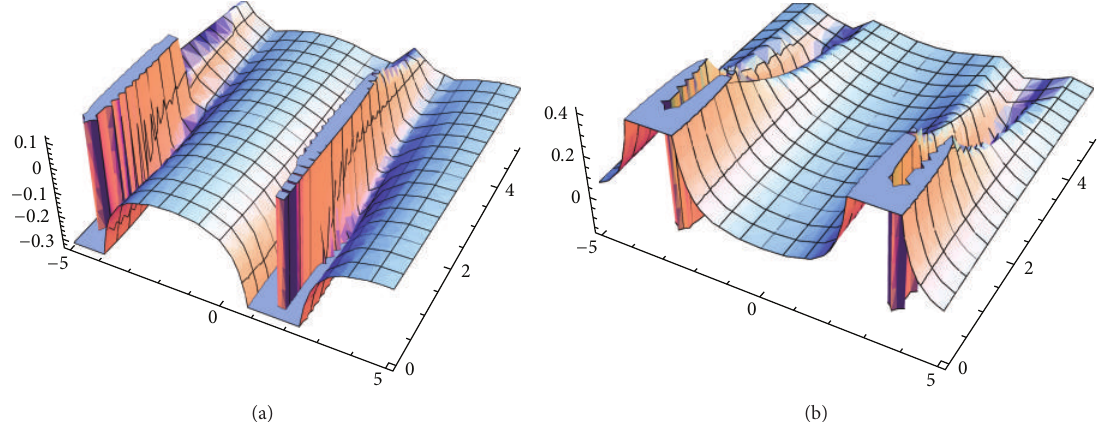
Figure 1: Graph of the solution 𝑢(𝑥,𝑡) from left to the right for (13) and (14).